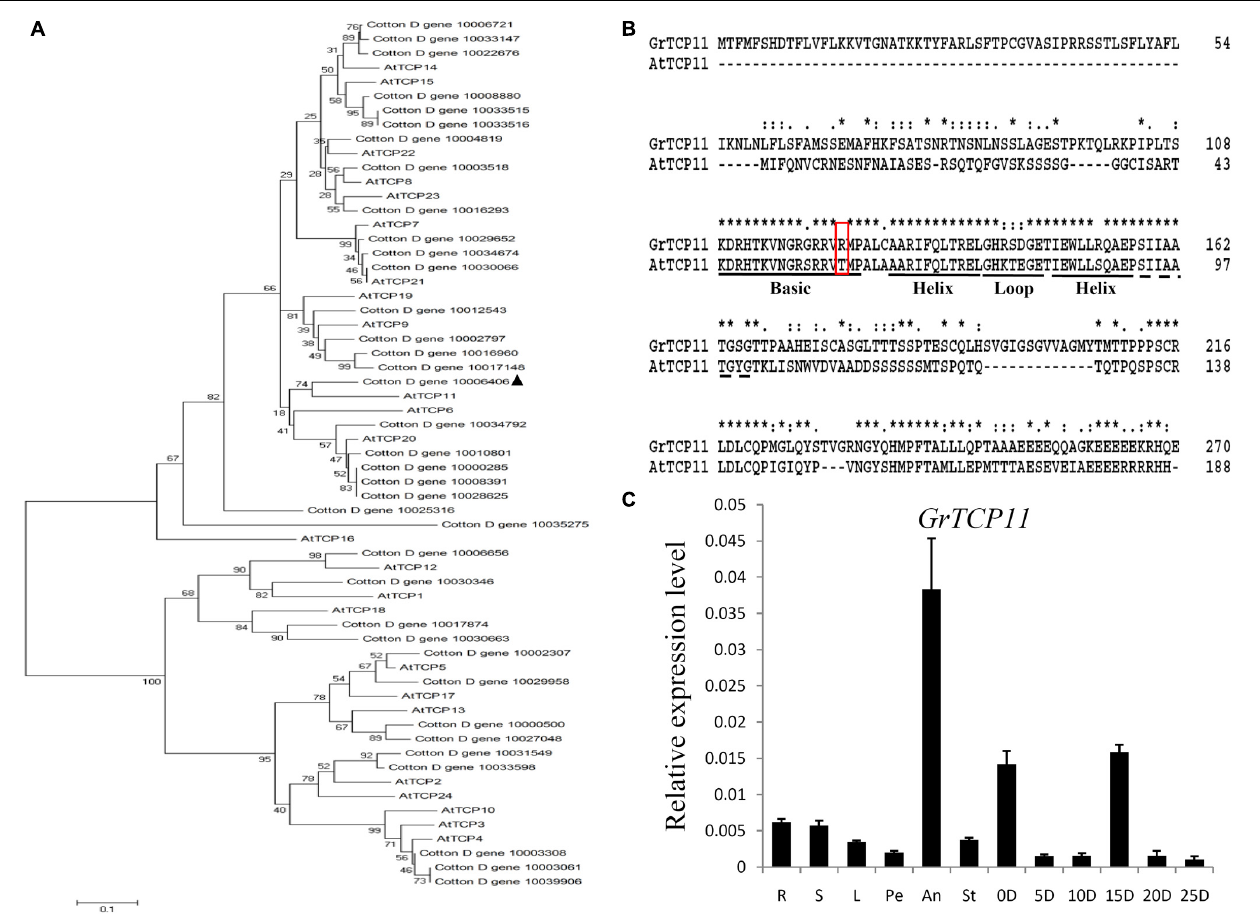
FIGURE 3 | Phylogenetic analysis, sequence alignment and expression analysis of GrTCP11 . (A) Phylogenetic relationships of TCP transcription factors from Gossypium raimondii and Arabidopsis . The unrooted phylogenetic tree was constructed using MEGA 6.0 with the neighbor-joining method and the bootstrap test involved 1000 iterations. GrTCP11 is marked with a solid triangle. (B) Alignment of the amino acid sequences of GrTCP11 and AtTCP15. The horizontal lines indicate the conserved teosinte branched1/cycloidea/proliferating cell factor1 (TCP) domain. The red box indicates the amino acid residue at position 15 of the TCP protein domain. (C) Relative expression level of GrTCP11 in various tissues, including root (R), stem (S), leaf (L), petal (Pe), anther (An), stigma (St) and fibers (0D and 5D: ovules with fibers at 0 and 5 days post-anthesis; 10D, 15D, 20D, and 25 D: fibers at 10, 15, 20, and 25 days post-anthesis) from Gossypium hirsutum cv.TM-1; expression of GrTCP11 was calculated relative to GhUB7 expression. Error bar on each mean value represents the standard deviation of three biological